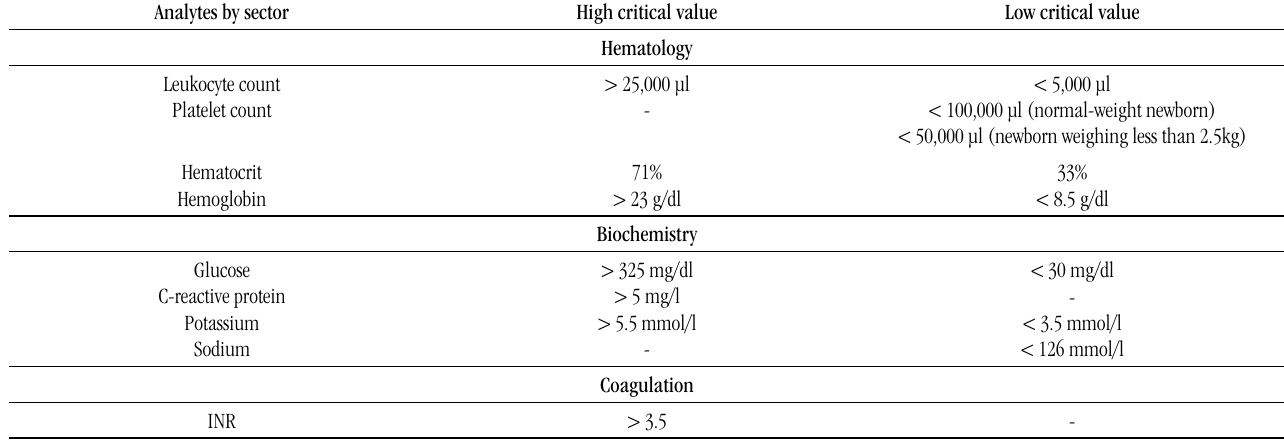
tABLE 3 – List of critical values, modified for pediatric patients, of